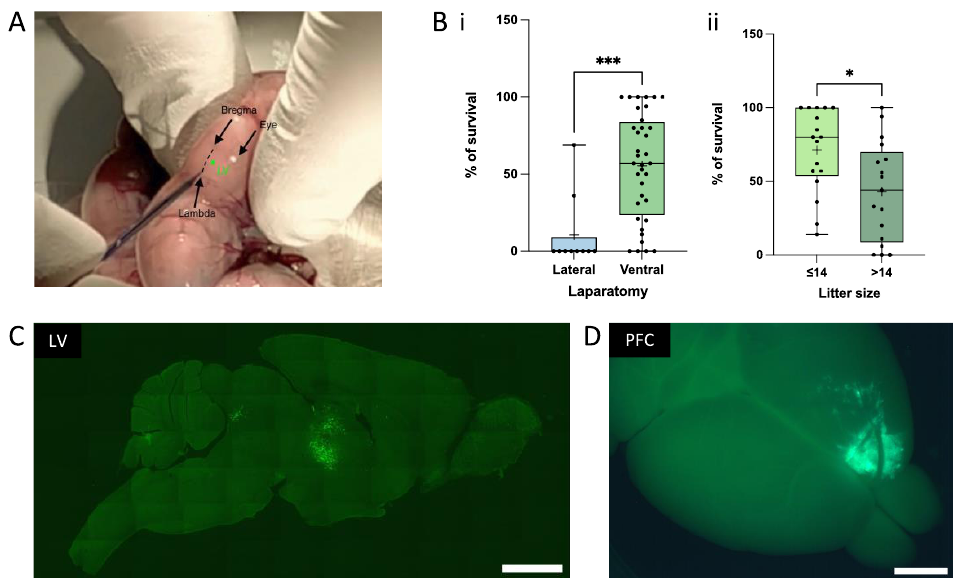
Figure 2. The in utero technique. ( A ) Illustration of the site of injection for Lateral Ventricle (LV) surgery. ( B ) Pup survival as a function of the laparotomy technique (Bi) and litter size (Bii). Pup survival is higher when the ventral laparotomy is performed on mice that have less than 14 embryos. Each point of the boxplot corresponds to the survival percentage in one litter. (* = p < 0.05; *** = p < 0.001, unpaired t -test). ( C ) Sagittal picture of a brain section at 1 MPT into LV taken with an epifluorescence microscope. Cells are labeled with GFP. ( D ) Illustration of a graft within the PFC at 1 MPT taken with an epifluorescence macroscope. Scale bars = 2 mm.